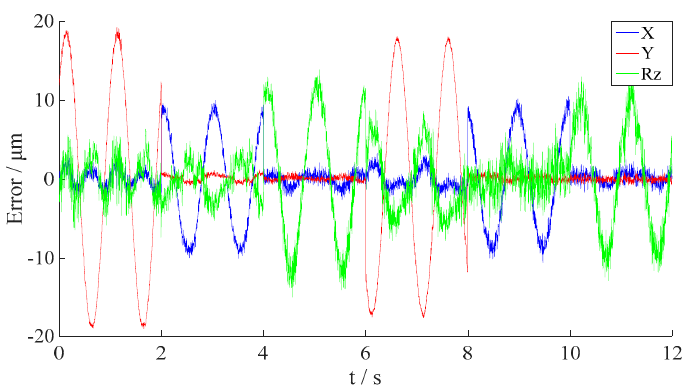
Figure 11. The output errors in horizontal 3-DOFs with the optimized parameters using Model (30). Table 4. The statistics of the horizontal 3-DOFs’ outputs with optimized parameters using Model (30). DOF X Y Rz RMSE